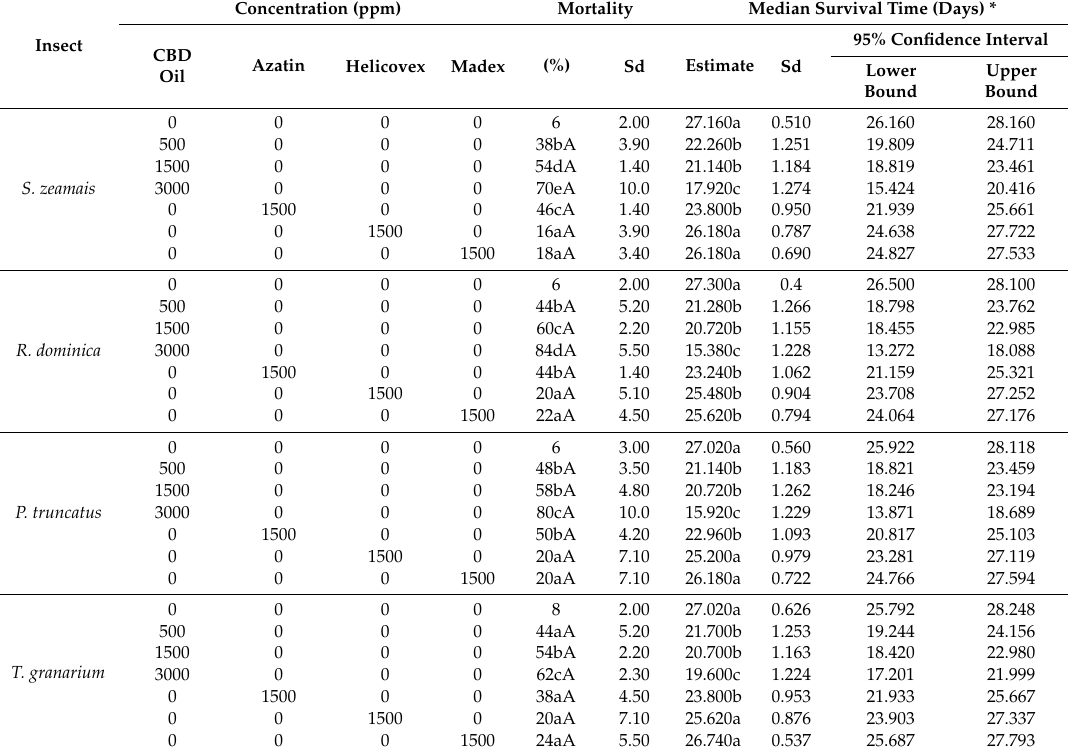
Table 1. Mean (%) mortality and median survival time (days) of adults of S. zeamais , R. dominica , P. truncatus and T. granarium treated separately with cannabidiol (CBD) oil, Azatin, Helicovex and Madex after 28 days. Mean% mortality for di ff erent concentrations or biopesticide, within the same insect and pathogen, followed by the same small letter are not significantly di ff erent. Mean% mortality for di ff erent insect, within the same concentrations or biopesticide, followed by the same capital letter are not significantly di ff erent (Bonferroni test, a = 0.05). Estimate Median survival time (days) of the same insect followed by the same small letter are not significantly di ff erent (Kaplan–Meier, a =